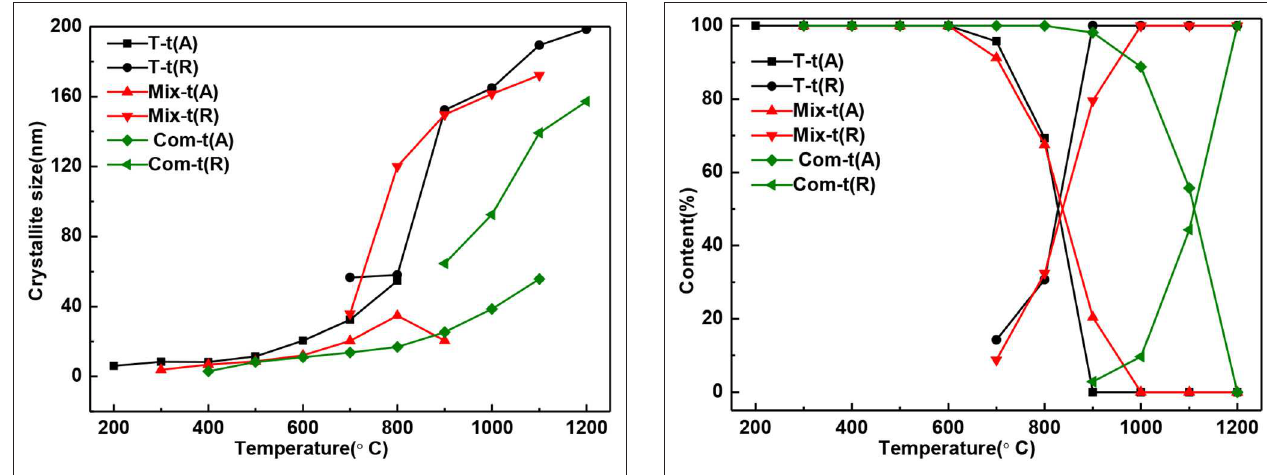
(Kameshima et al., 2009; Huo et al., 2018), and the inhibition effect of the Com is greater than that of Mix.